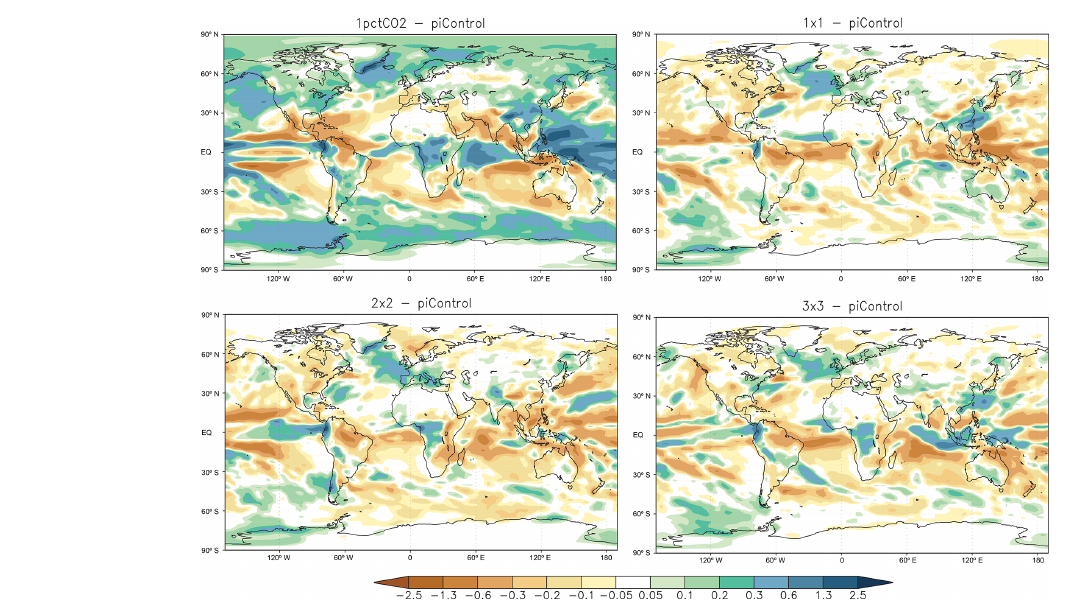
Figure 20. Same as Fig. 19 but for precipitation changes in the design model. Values are in mmday − 1 .